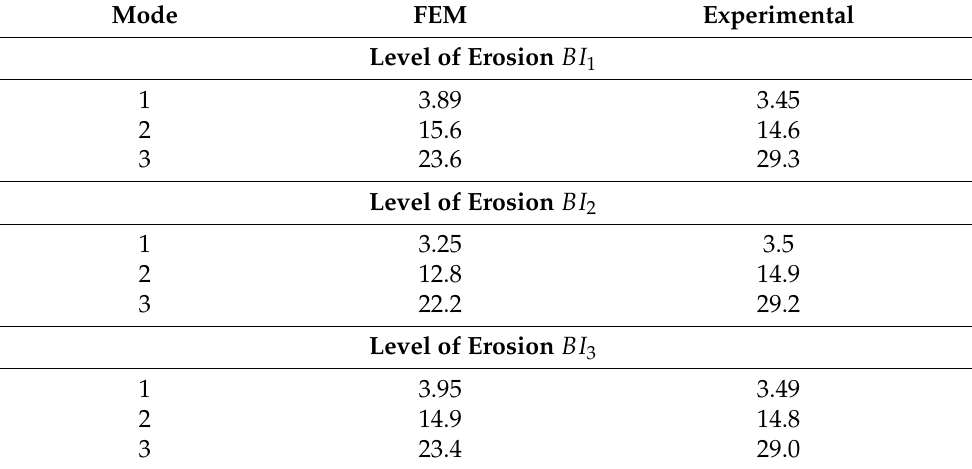
Table 5. Modal analysis of the simulated (FEM) and physical (experimental) blade under different erosion conditions; values given in